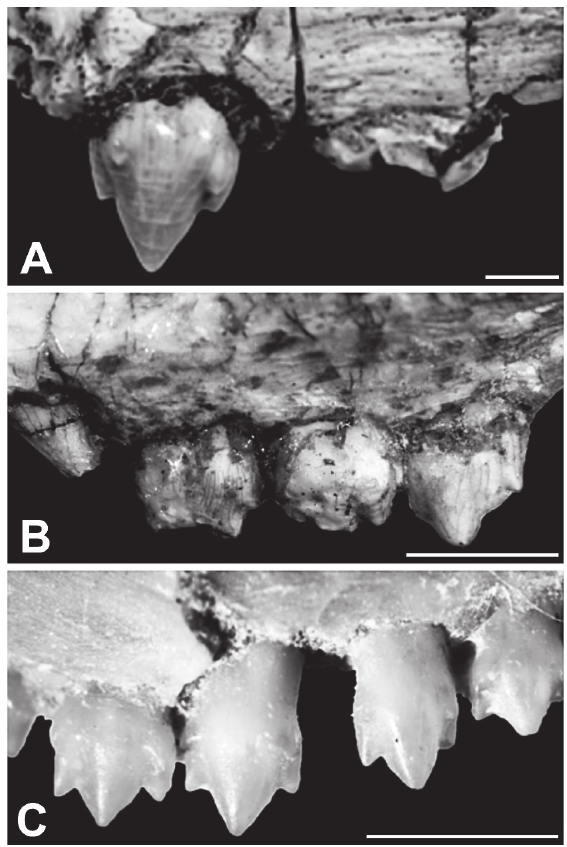
Fig. 5 - Comparisons of upper postcanines. A: Botucaraitherium belarminoi gen. nov. et sp. nov (Holotype MMACR-PV-003-T) in left labial view. B: Prozostrodon brasiliensis (Holotype UFRGS- PV-0248-T) in left labial view. C: Brasilodon quadrangularis (Holotype UFRGS-PV-0611-T) in right labial view. Scale bar equals